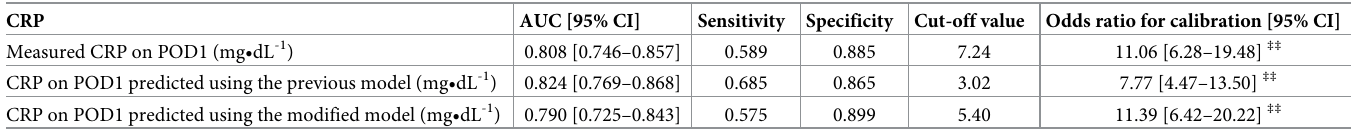
Table 2. Receiver operating characteristic curve analysis between CRP levels and major complications (Clavien-Dindo class � IIIa) in the validation cohort. CRP Measured CRP on POD1 (mg•dL -1 )